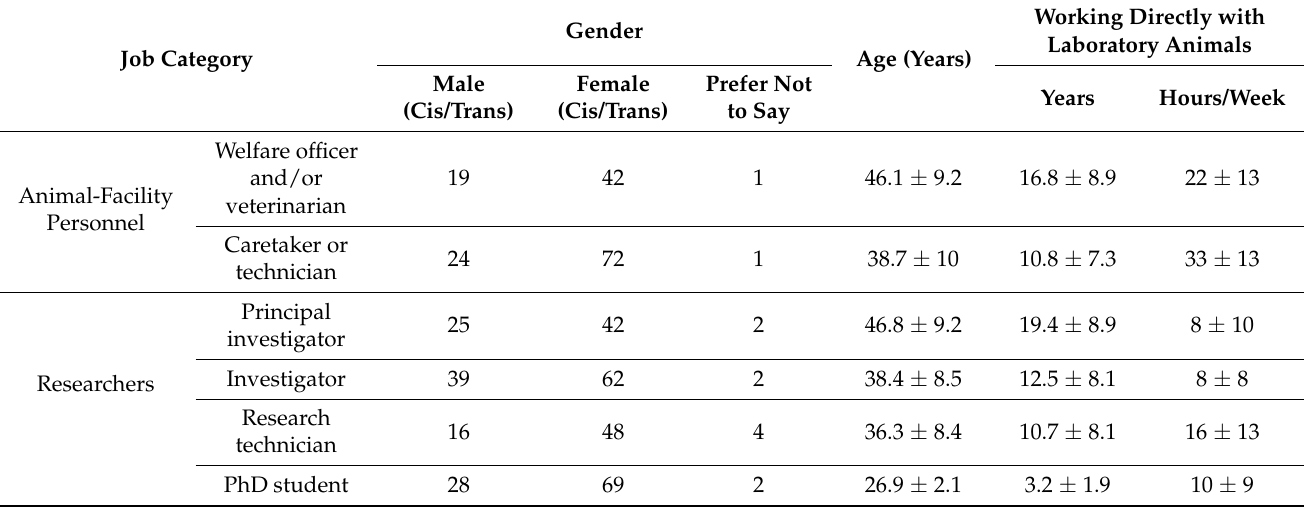
Table 1. Participants gender, age and reported working years and hours-per-week by job category. Data are expressed as total numbers or mean ±